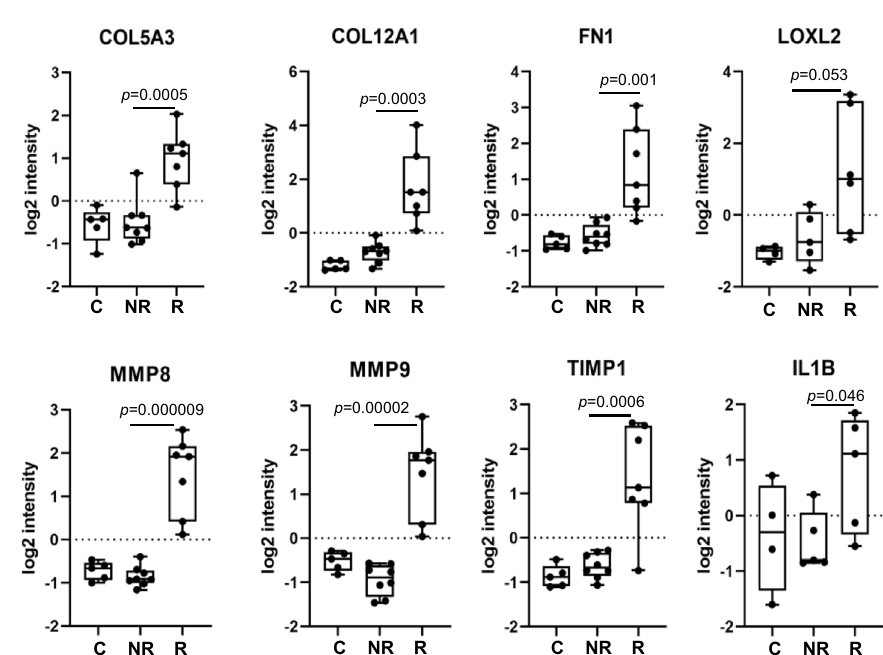
Fig. 3 Elevated extracellular matrix (ECM) signaling is associated with recurrence. a The ECM ligand-receptor interaction network is up-regulated in the recurrent tumors. The diagram was recreated based on the KEGG pathway ID hsa04512. Changes in the protein level (Log2(R/NR)) is color-coded with red indicating increased protein expression. VLA very late antigen. b Representative examples of ECM and/or fi brosis regulators with signi fi cant differences in protein expression between the R and NR groups. P values shown were based on Student ’ s t -test. The box in the box plot extends from the 25th to the 75th percentile. The whiskers go down to the smallest value and up to the largest. n = 8 for the NR group, and n = 7 for the R Elevated phosphorylation of DDR1, PTK2 (FAK), EGFR, and kinases JAK1, TYK2, and JAK3 all had decreased phosphoryla- FER was also detected in the R group, suggesting increased tion in the R group, consistent with compromised T cell and B integrin, collagen, and cytoskeletal signaling in the recurrent cell function in the recurrent tumors. tumors. Notwithstanding these observations, the T/B cell protein In addition to the TKs, a large number of STKs were kinases LCK, LYN, BTK, and SYK, and the cytokine signaling signi fi cantly differentially expressed in the recurrent tumors.